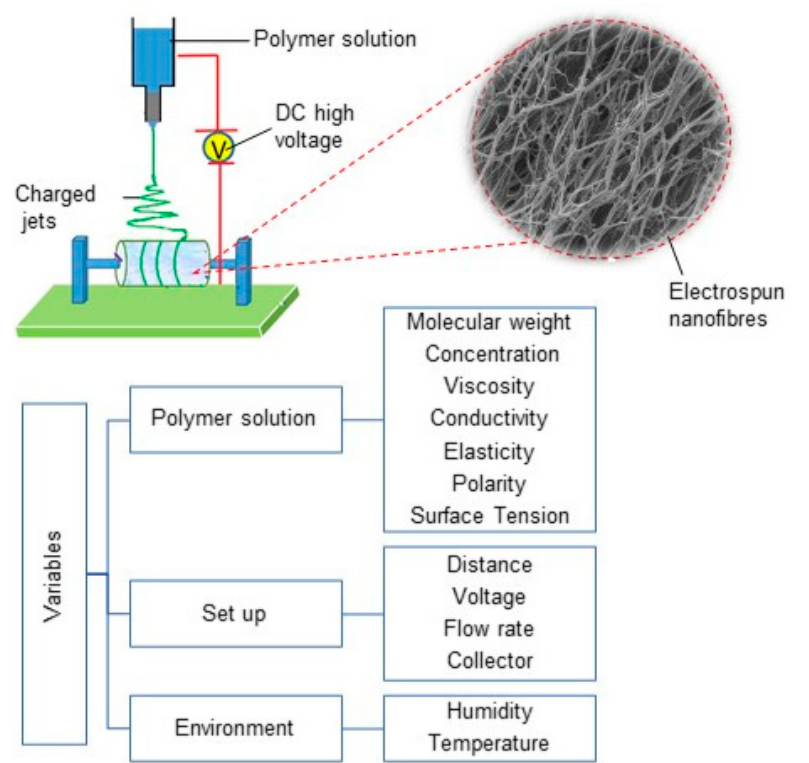
Figure 1. Electrospinning set-up diagram, electrospun nanofibres and different variables in electro- spinning process.